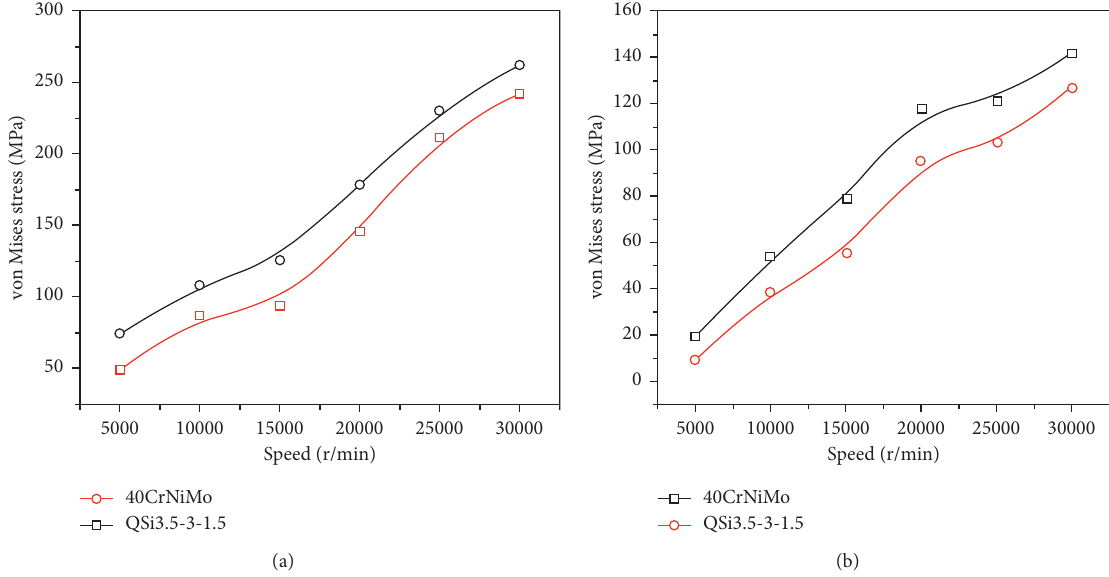
Figure 15: Influence of cage material on cage stress at the stage of start-up and stop. (a) Cage stress at the stage of start-up. (b) Cage stress at the stage of